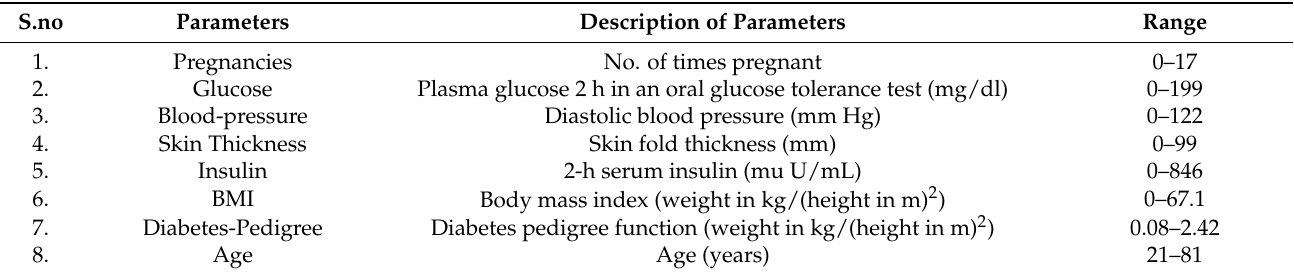
Table 1. PIMA Diabetes real-time